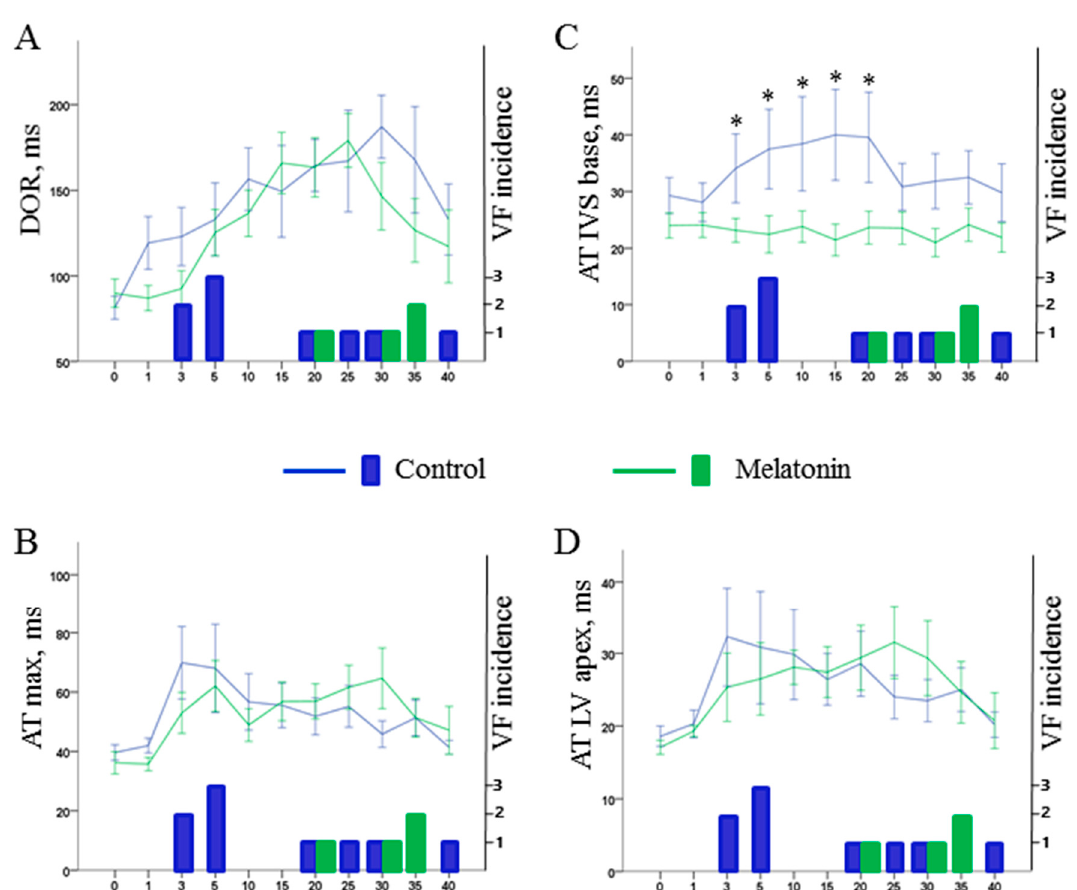
Figure 6. Dynamics of electrophysiological variables associated with ventricular fibrillation (VF) incidence during ischemic exposure, i.e., dispersion of repolarization (DOR, panel A ), maximal activation time (AT max, panel B ), local activation time in the base of interventricular septum (AT IVS base, panel C ) and local activation time in the left ventricular apex (AT LV apex, panel D ). Data are presented as mean ± SEM. Numbers of VF episodes at given time-points are presented in the lower part of each panel. See abrupt rise of ATs corresponding to the early cluster of VF and gradual increase of DOR with its maximum in the period of delayed VFs. Since pronounced ischemic changes were consistently observed in the LV apex, see similar time-courses of AT max and AT LV apex during coronary occlusion. * denotes statistically significant difference between control and melatonin-treated animals.